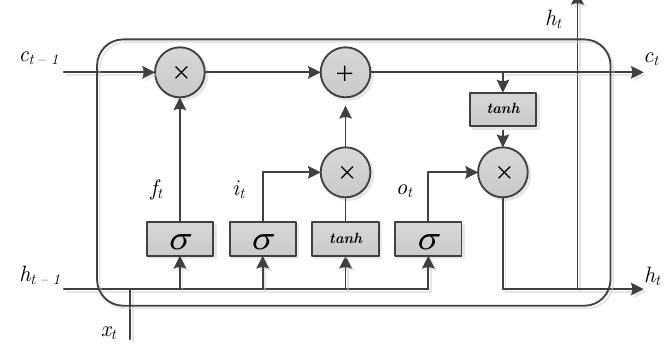
Figure 3. Long short-term memory (LSTM) cell.